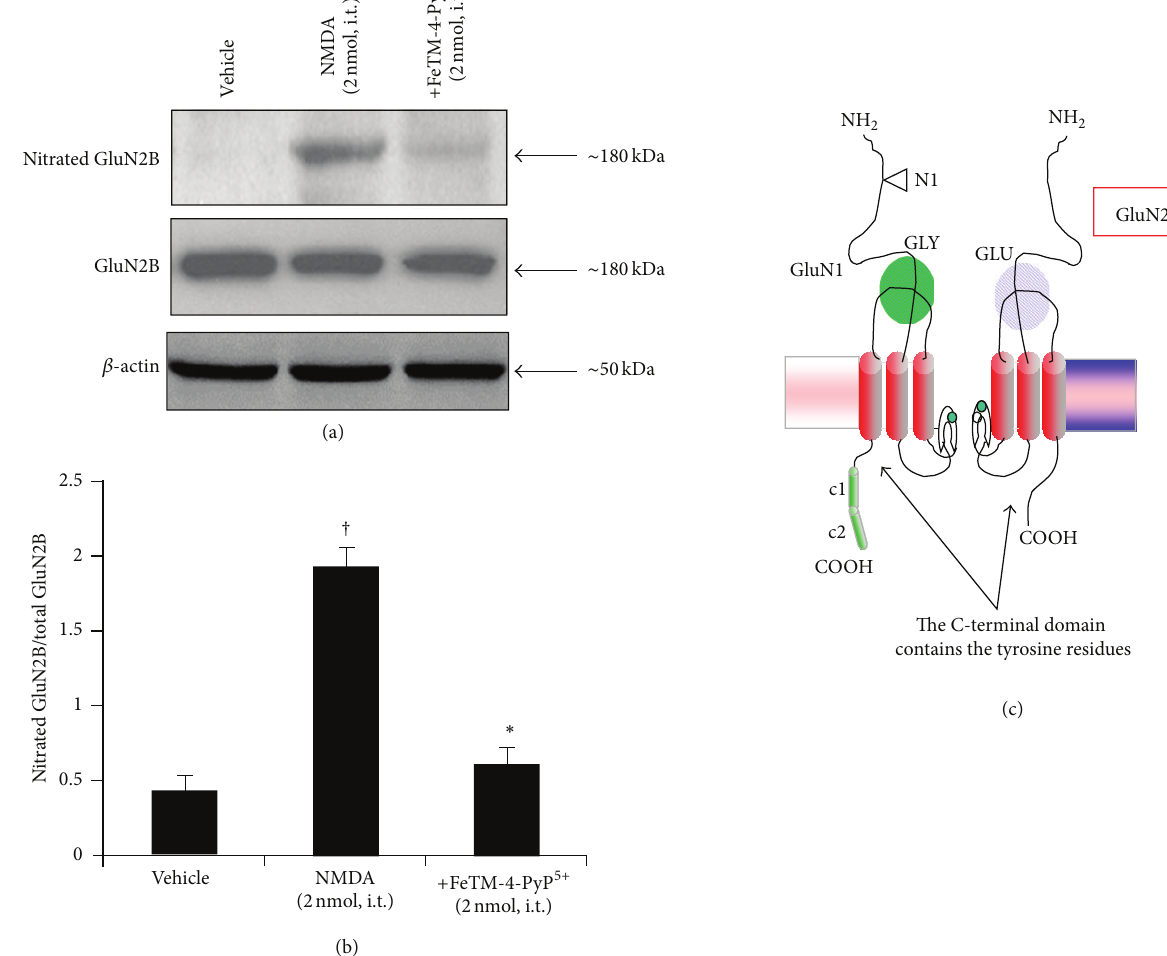
Figure 3: Inhibition of NMDA-induced hyperalgesia by FeTM-4-PyP 5+ is associated with inhibition of spinal protein nitration ((a)–(c)). As shown by immunoprecipitation, the time at which the NMDA mediated hyperalgesia was at its peak (40 minutes), nitration of GluN2B was observed at the level of the spinal cord ((a), (b)). FeTM-4-PyP 5+ (2nmol given 15min before NMDA) attenuates spinal GluN2B nitration ((a), (b)). Immunoprecipitation data shown in (a) are representative of at least 6 gels from 3 different animals performed on different days. Bar graph in (b) represents quantification by densitometric analysis. No difference for GluN2B or 𝛽 -actin expression was detected among the lanes in these conditions. † 𝑃 < 0.001 compared to vehicle and ∗ 𝑃 < 0.001 compared to NMDA